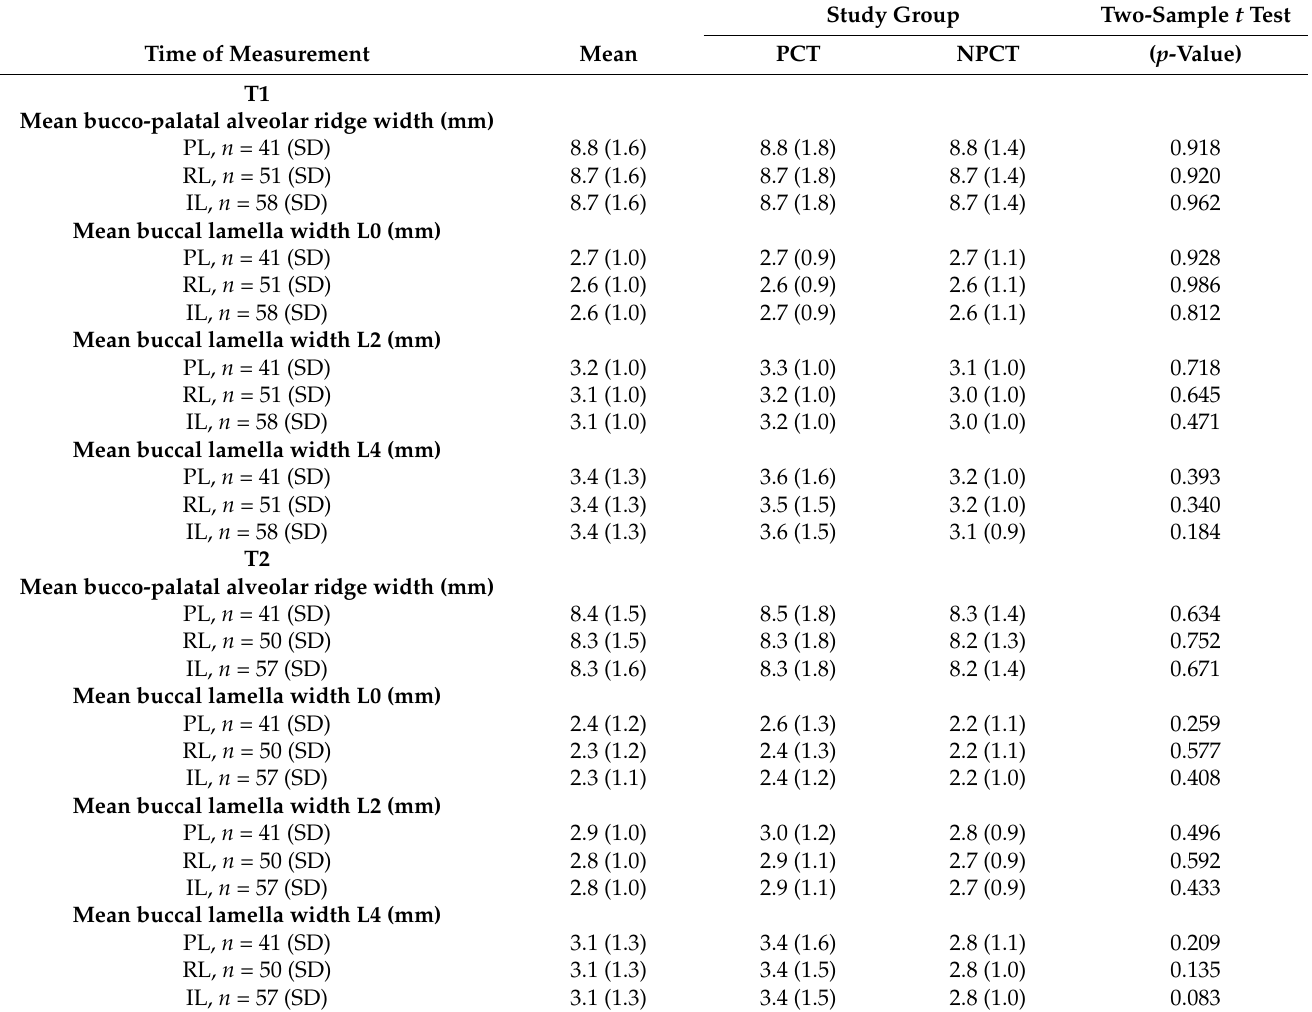
Table 3. Mean values of the CBCT evaluations at time points T1 and T2. Study Group Two-Sample t